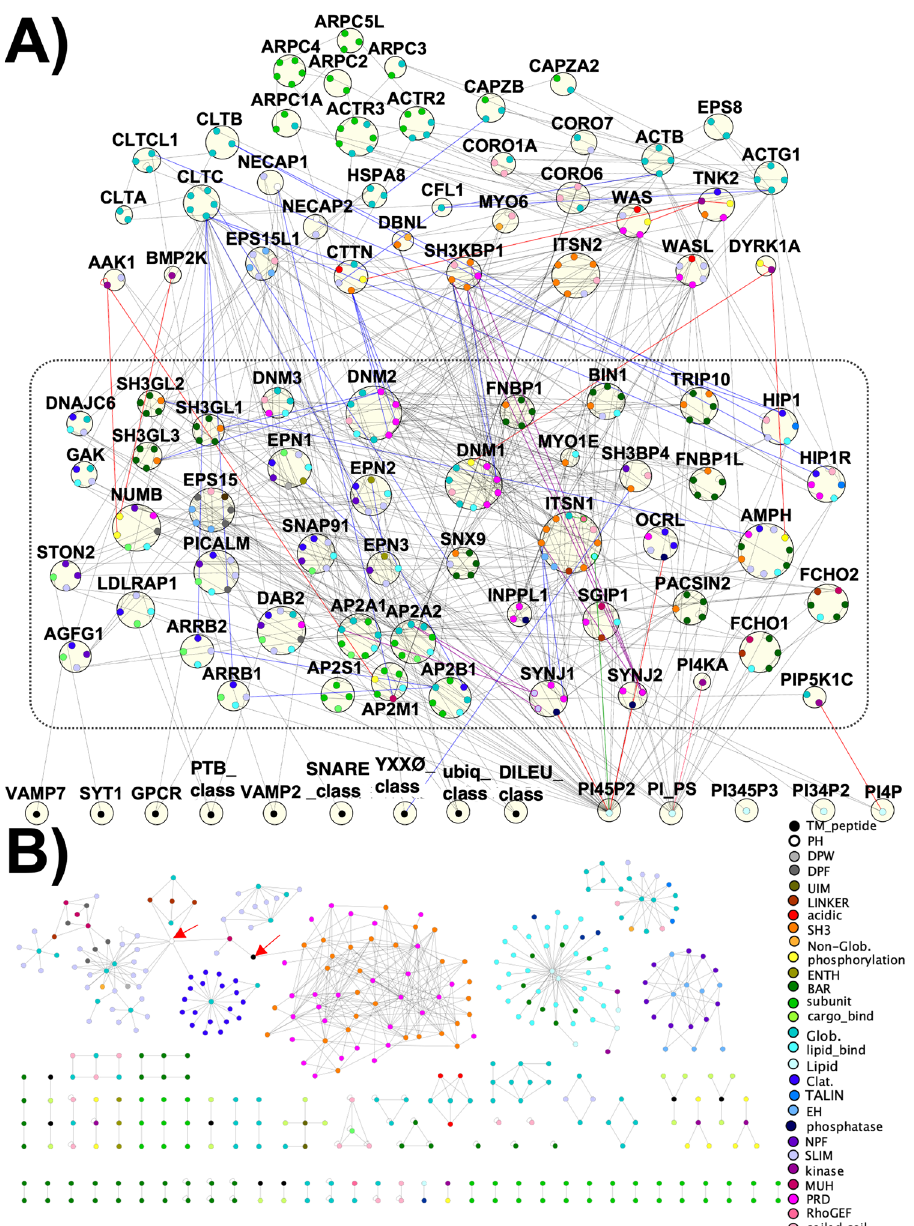
Figure 2. The interface-resolved PPIN for our mammalian CME proteome reveals extensive and redundant capacity to assemble and localize to the membrane. ( A ) The CME PPIN includes the 82 proteins from Fig. 1 labeled by gene name, as well as 5 phospholipids (PI(4,5)P 2 , a phosphatidylinositol/phosphaditylserine group/ PI_PS, PI(3,4)P 2 , PI(4)P, and PI(3,4,5)P 3 ) and 9 groups of transmembrane receptors or cargo along the bottom row, labeled by gene name or class/grouping. The box contains the set of proteins that directly bind to lipids and cargo types. Proteins that do not bind to lipids nor cargoes are located directly above the dashed black box. Unique interfaces are shown, color-labeled according to interface type. Red edges indicate enzymatic reactions, and blue edges indicate some conditionality or regulation of the interaction. Purple edges are isoform specific. ( B ) Map of interface-resolved PPIs in the network. When separated from the parent proteins, the interface- interaction network (IIN) illustrates the selectivity of binding pairs, visibly encoded in the highly disconnected modules. Within each module, interfaces typically interact in motifs that include selective pairs or pairs-of-pairs (square motifs), or with a central hub interface surrounded by multiple spokes of one specific domain. Red arrows indicate noted ‘bridging’ nodes. BAR: Bin-Amphiphysin-Rvs domain; CC: coiled coil; Clat.: clathrin- box motif; DPF: Aspartic Acid(D)-Proline(P)-Phenylalanine(F) motif; DPW: Aspartic Acid(D)-Proline(P)- Tryptophan(W) motif; EH: Eps15 Homology; NPF Asparagine(N) Proline(P) Phenylalanine(F) domain;